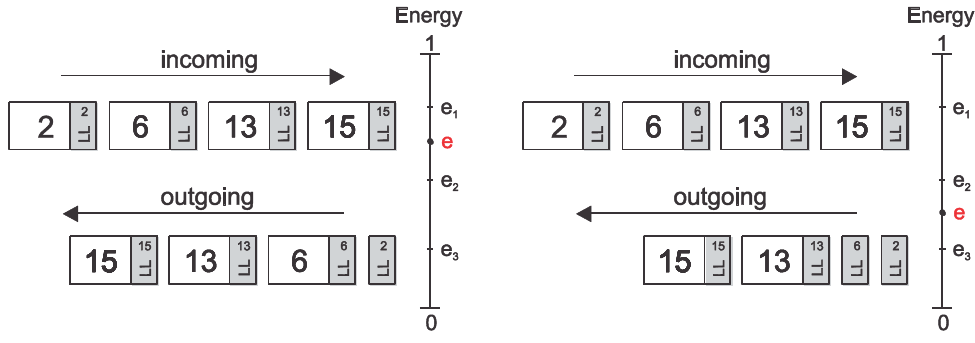
Figure 4. Threshold-based packet relaying, regarding the sensing relevancies of source nodes and DWT